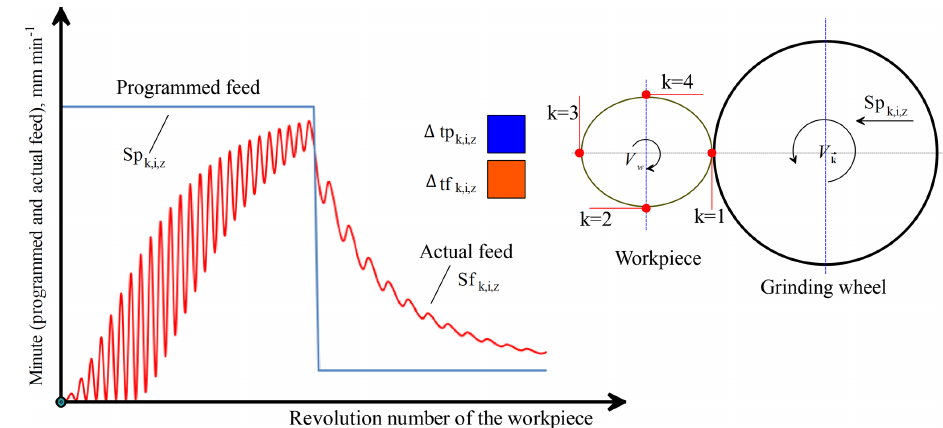
Figure 2. The graphs of minute feeds (programmed and actual) in a two-step grinding cycle. Points of actual feed rate are calculated by four radiuses on every round of